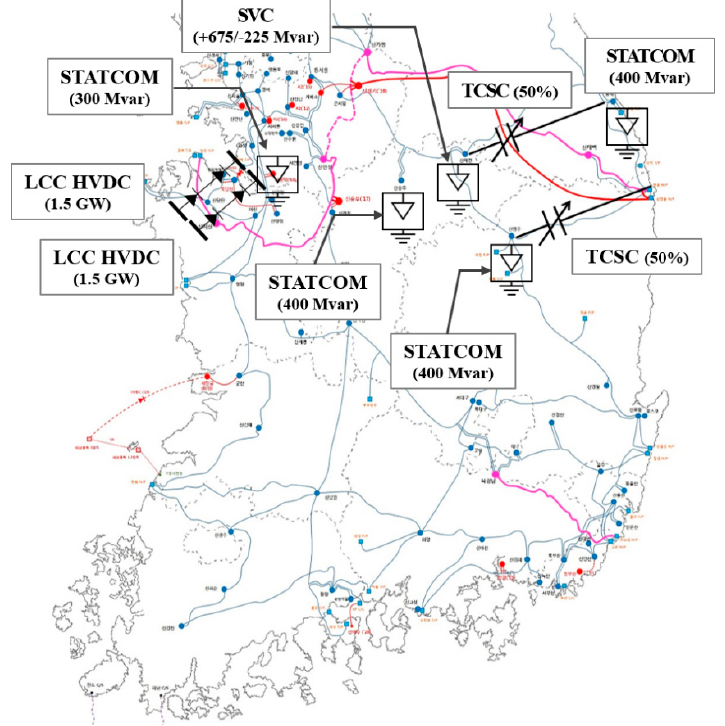
Figure 1. HVDC, FACTS in the Korean power system.